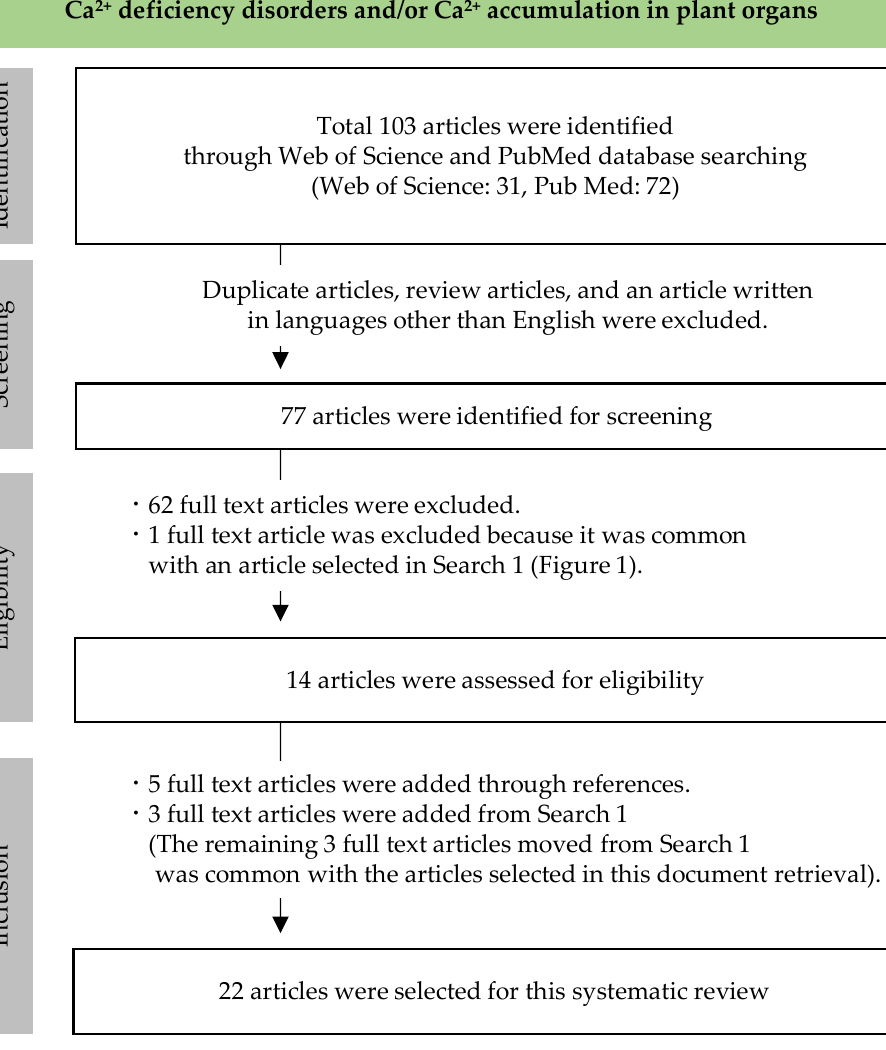
Figure 2. Systematic review flow chart for Search 2.